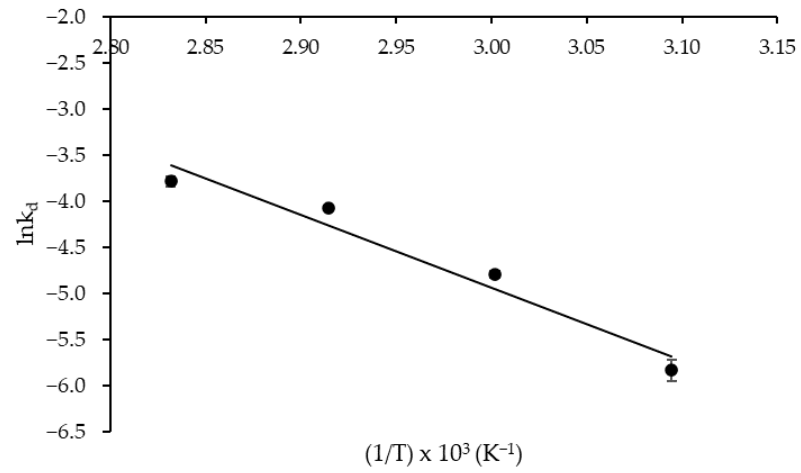
Figure 5. Arrhenius-type plot used to estimate the activation energy of thermal denaturation of Aspergillus tamarii URM4634 protease produced by sequential fermentation using wheat bran as a substrate.